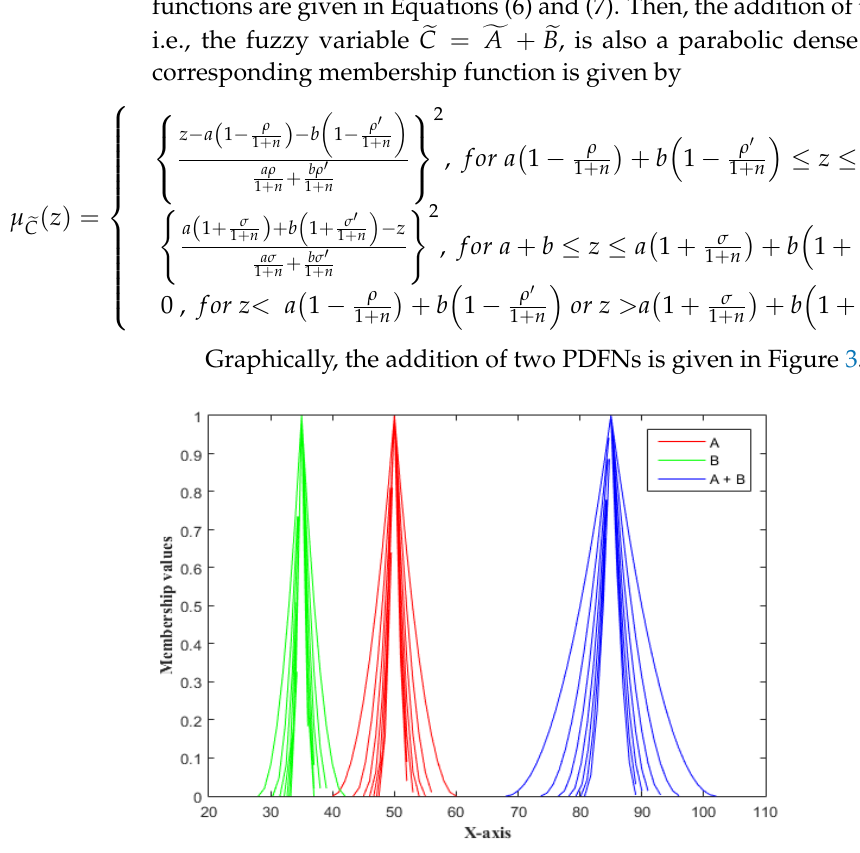
Figure 3. Addition of two parabolic dense fuzzy numbers.